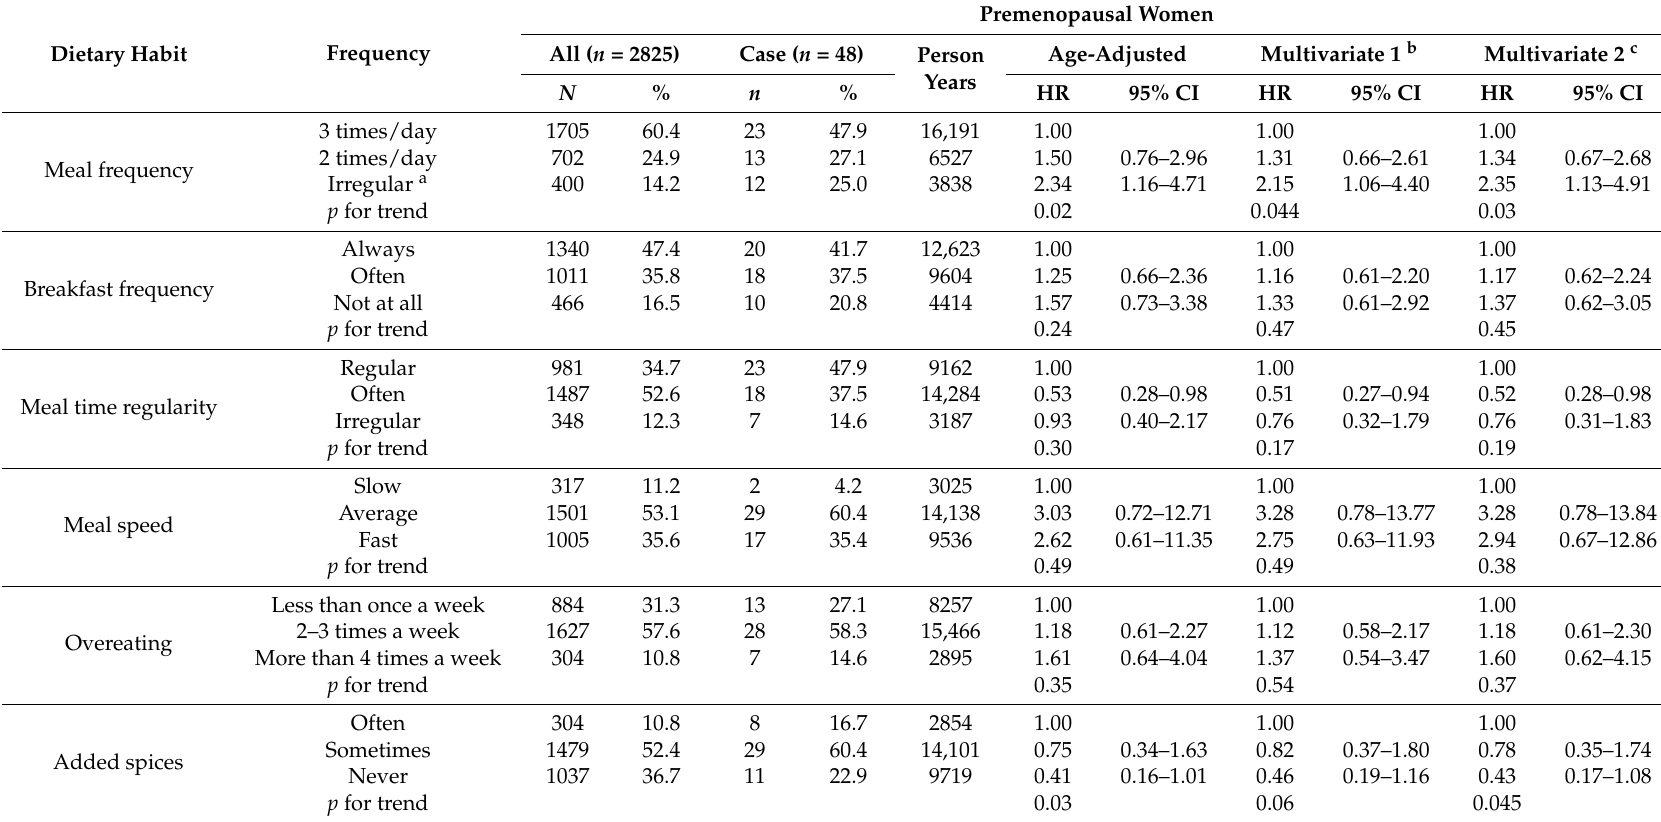
Table 6. Six dietary habits and their associations with breast cancer risk in premenopausal